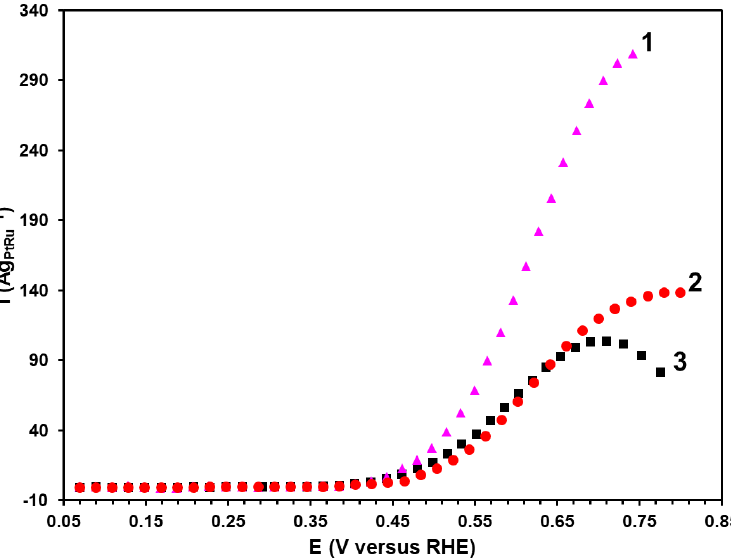
Figure 6. The current–voltage curves for the PtRu/C catalysts. The electrolyte is 0.5 М CH 3 OH + 0.1 М HClO 4 saturated with argon at the atmospheric pressure. 1 — P; 2 — BH; 3 — PtRu-AA.